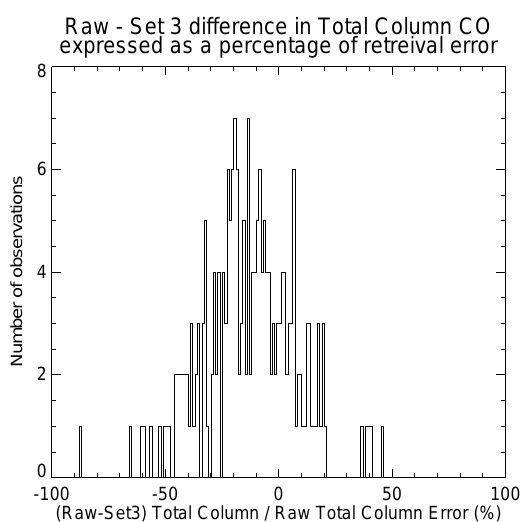
Fig. 11. Difference in total column CO amount retrieved from set 3 eigenvectors and raw radiances, expressed as a fraction of retrieval error.